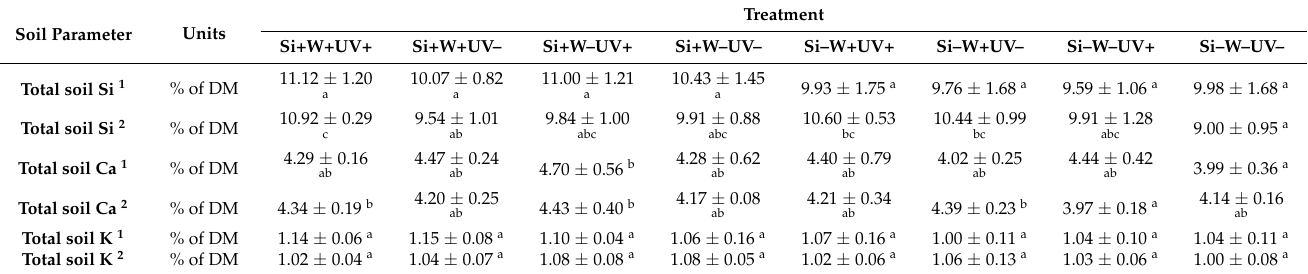
Data are means ± SD; n = 5. Different superscript letters within each row indicate significant differences ( p ≤ 0.05; Duncan tests). DM, dry matter. 1 After